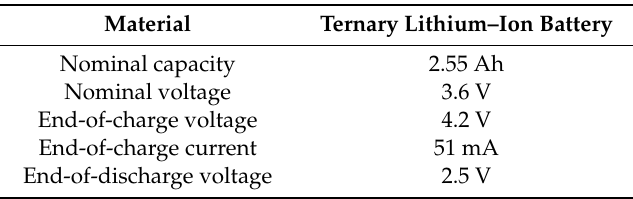
Table 1. The specifications of the battery